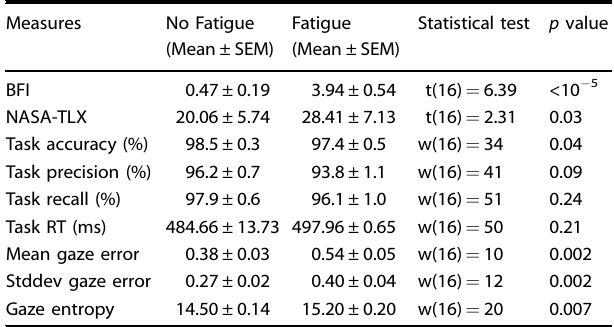
Table 1. Change in mental fatigue scores, task and gaze features for study